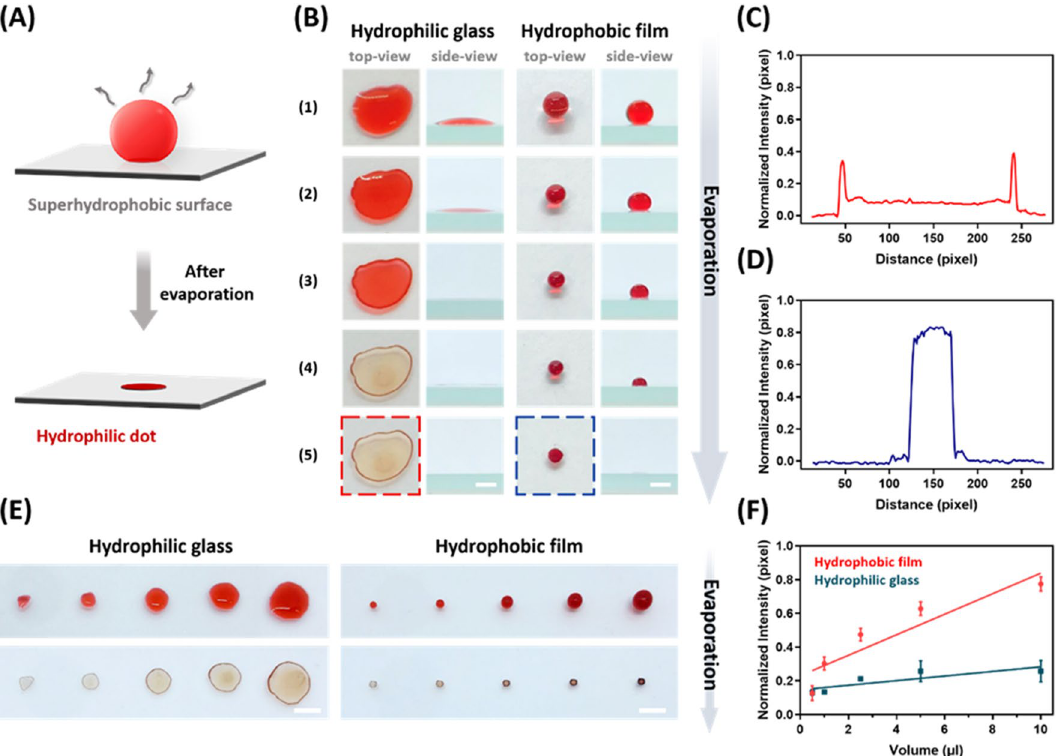
Figure 4. ( A ) Schematic illustration of the droplet returning to a homogeneous deposition after droplet evaporation. ( B ) Morphology change (top-view and side-view) of 10 μL droplet evaporation on the hydrophilic glass and hydrophobic film (the scale bar is 10 mm). ( C ) The intensity analysis of deposit dot on hydrophilic glass. ( D ) The intensity analysis of deposited dot on hydrophobic film. ( E ) The optical images of droplet evaporation deposited on different substrates with different droplet volumes (the scale bar is 20 mm). ( F ) The relationship between deposited dot intensity and droplet volume is based on the different